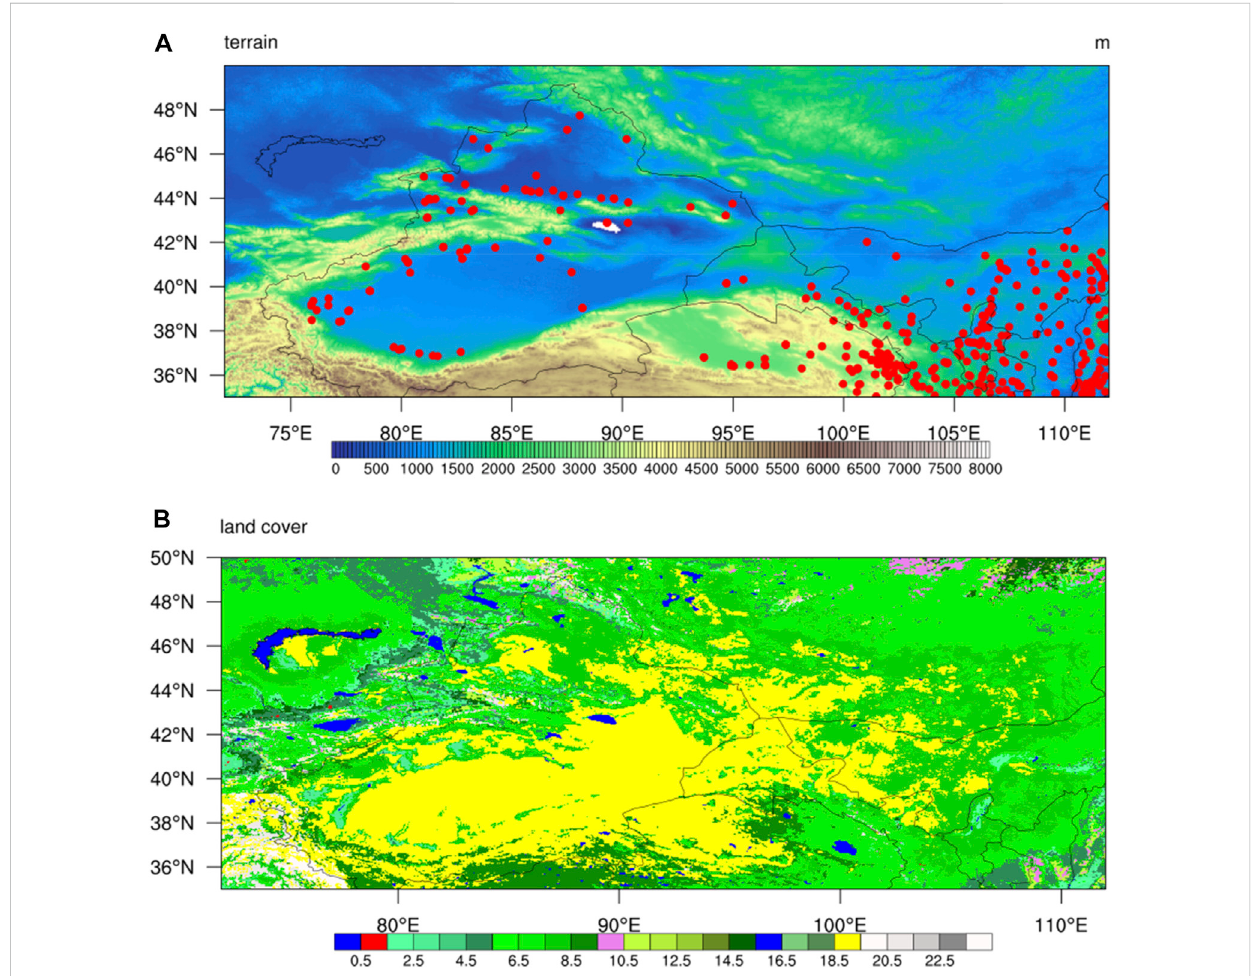
FIGURE 1 (A) Shaded relief elevation above sea level (m) and the locations of 358 soil moisture sites (red dots); (B) land cover based on USGS categories. (1. urban and built-up land. 2. Drylandcropland and pasture. 3. Irrigated cropland and pasture. 4. Mixed dryland/irrigated cropland and pasture. 5. Cropland/ grassland mosaic. 6. Cropland/woodland mosaic. 7. Grassland. 8. Shrubland. 9. Mixed shrubland/grassland. 10. Savanna. 11. Deciduous broadleaf forest. 12. Deciduous needleleaf forest. 13. Evergreen broadleaf forest. 14. Evergreen needleleaf forest. 15. Mixed forest. 16. Water bodies. 17. Herbaceous wetland. 18. Wooded wetland. 19. Barren or sparsely vegetated. 20. Herbaceous tundra. 21. Wooded tundra. 22. Mixed tundra. 23. Bare-ground tundra. 24. Snow or